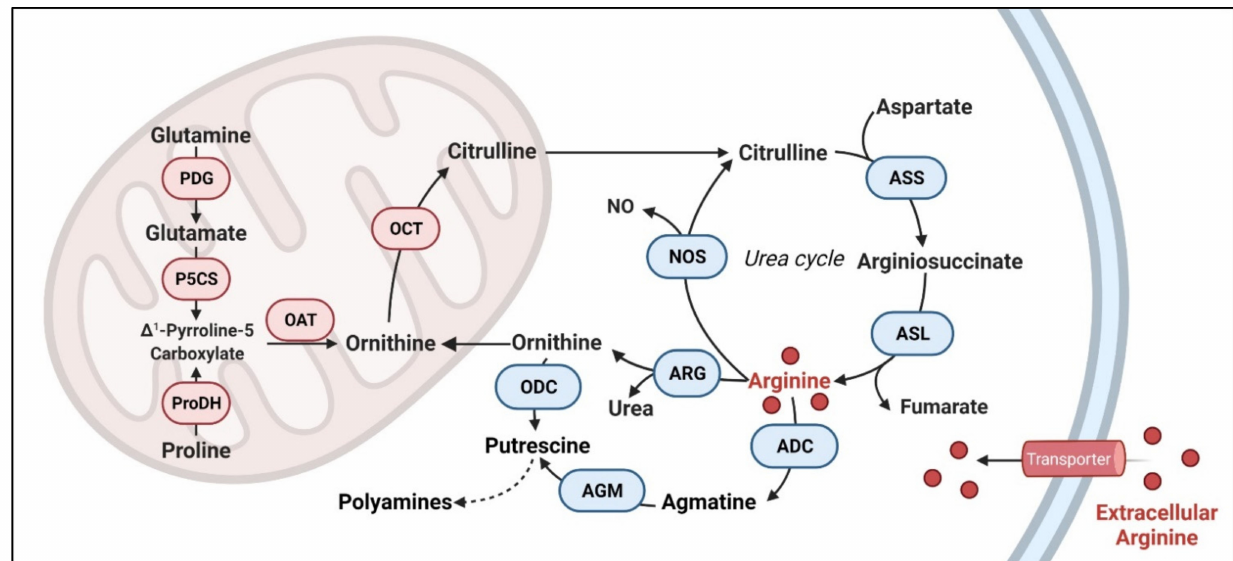
Figure 1. Arginine-related metabolic pathways. In normal cells, arginine can be directly transported into the cell or synthesized from citrulline and aspartate in the urea cycle. The resources of citrulline include glutamine, glutamate and proline. Arginine can be converted into nitric oxide (NO), urea and agmatine. Agmatine and ornithine are important resource for putrescine, which is a key precursor for polyamines. ASS: argininosuccinate synthetase, ASL: argininosuccinate lyase, ADC: arginine decarboxylase, AGM: agmatinase, ODC: ornithine decarboxylase, ARG: arginase, NOS: nitric oxide synthase, OCT: ornithine carbamoyl transferase, OAT: ornithine aminotransferase, PDG: phosphate-dependent glutaminase, P5CS: pyrroline-5-carboxylate synthase, ProDH: proline